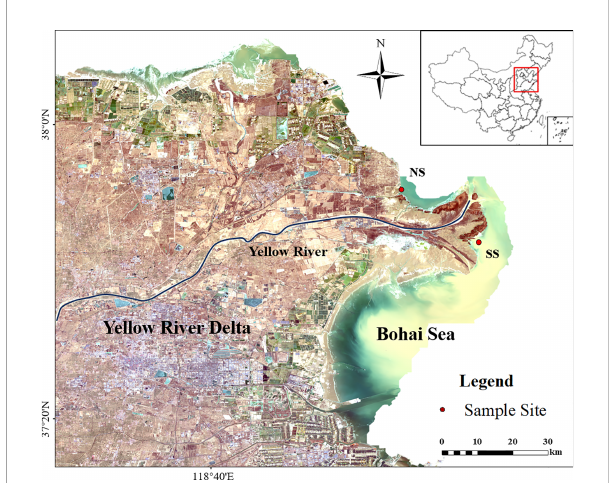
FIGURE 1 Location of the study area and sampling sites. (NS) Northern shore; (SS)Southern shore. The distribution of suspended sediment in seawater (in bottle green) around YRE is shown in